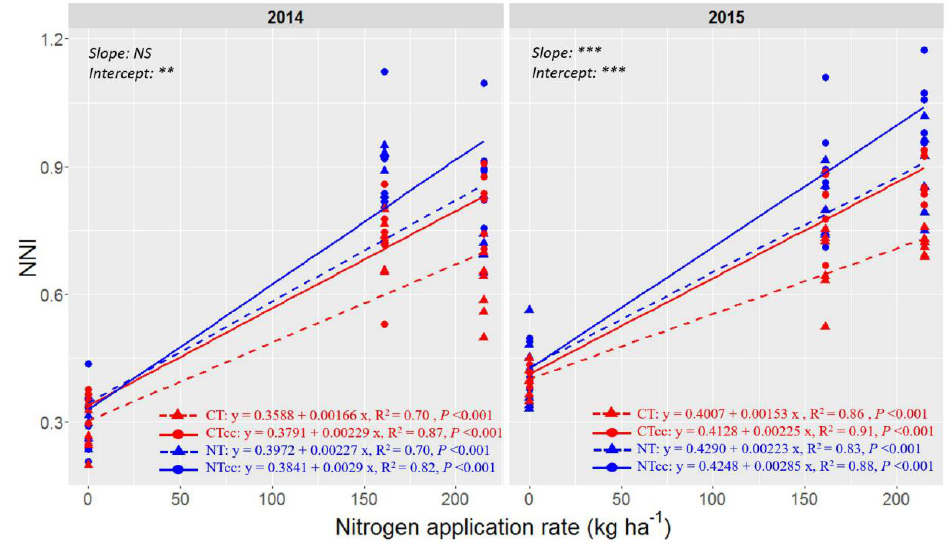
Figure 4. Nitrogen nutrition index (NNI) of wheat as a function of N application rate grown with four different tillage treatments in 2014 and 2015. NTcc: No-till with cover crops. NT: No-till without cover crops. CTcc: Conventional tillage with cover crops. CT: Conventional tillage without cover crops. Slopes and intercepts obtained with the four tillage treatments were evaluated using analysis of covariance (ANCOVA). ** and *** = significant at 0.01, 0.001 probability level respectively, as indicated on the top left hand side of the